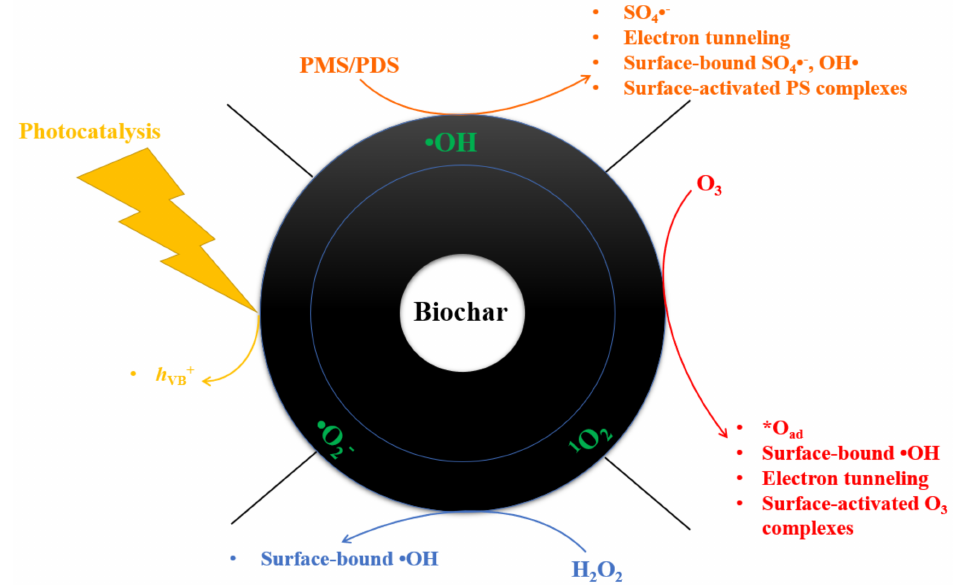
Figure 4. Produced active species in biochar during different AOPs